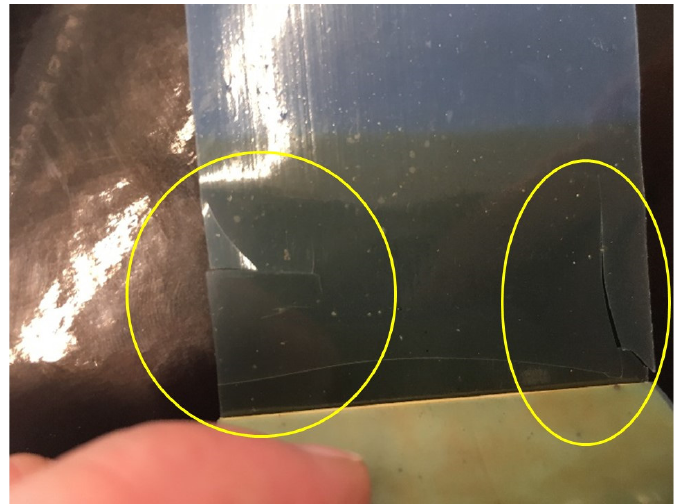
Figure 20. Membrane T7482-8 broke after aging for 168 days and could not be tested for adhesive strength when taped.